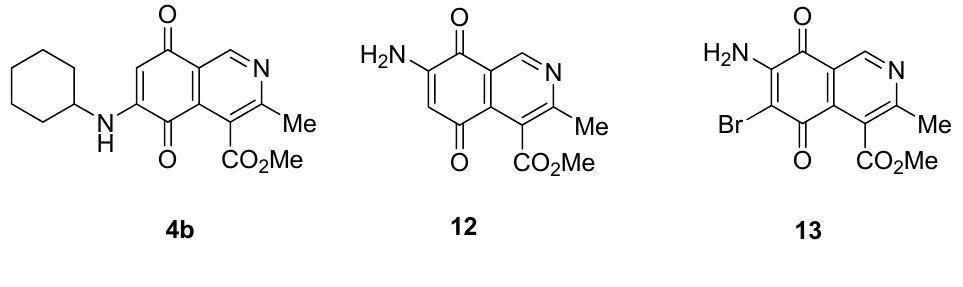
Figure 3. Structures of the isoquinolinequinones selected as the most significant antitumor